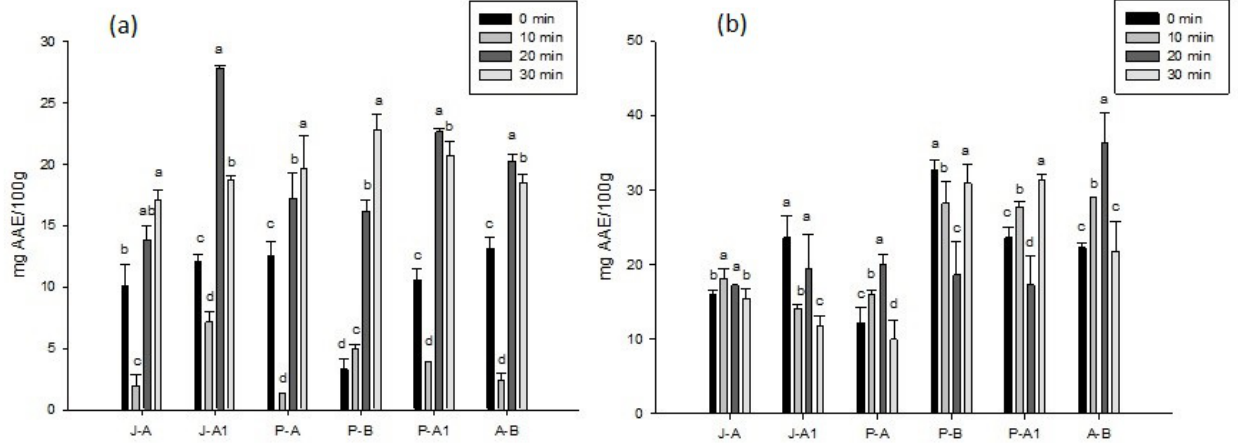
Figure 2. Effects of different ultrasound times (0, 10, 20, 30 min) on the antioxidant activity of different honeys: ( a ) ABTS and ( b ) DPPH. The results are expressed as means ± standard deviation. Different letters represent significant differences ( p < 0.05) between treatments.